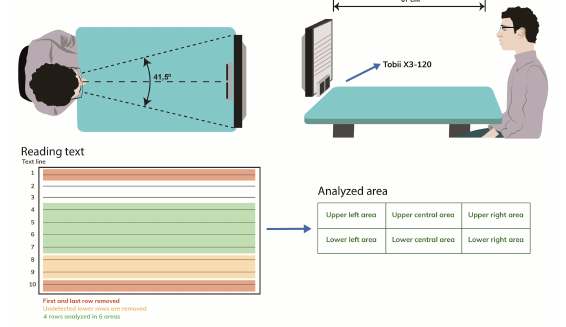
Figure 2. Scheme of the evaluation of EMs using eye tracking technology. Characteristics of the reading test indicating the different reading areas analyzed (rows and